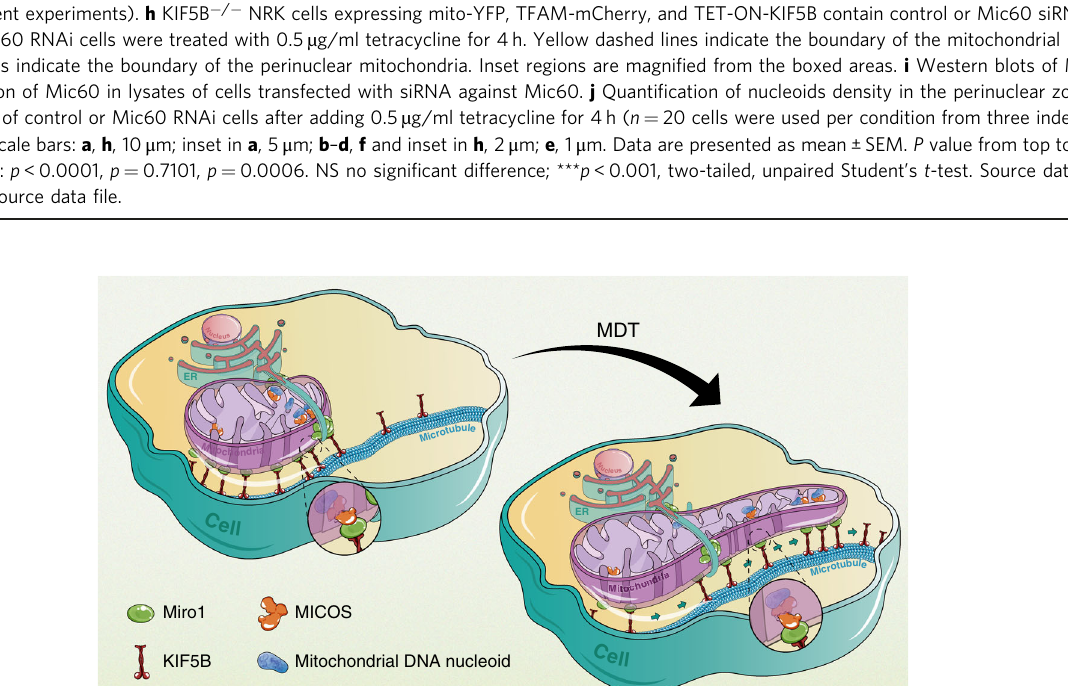
Fig. 6 The role of MDT in the partitioning of mitochondrial DNA nucleoids. At the ER – mitochondria contact sites, nucleoids interact with the inner membrane protein complex MICOS. MICOS is associated with the outer membrane protein Miro1, which is concentrated at the ER – mitochondria contact sites and recruits KIF5B motors on the mitochondria. When KIF5B-driven dynamic tubulation happens, nucleoids are transported via the interaction axis of dilution. We also used horseradish peroxidase-conjugated goat anti-rabbit (7074 S, Cell Signaling Technology, 1:5000 dilution) or goat anti-mouse secondary antibodies (31436, Invitrogen, 1:5000 dilution) and the signal was detected with SuperSignal West Pico PLUS Chemiluminescent Substrate (ThermoFisher Scienti fi c). Image lab (version 5.0) was used for western blotting images collection. Uncropped blots can be found in the Source data fi le. Immunoprecipitation . Cells were lysed in lysis buffer (25mM Tris-HCl pH 7.4; 1% NP-40; 150mM NaCl; 1mM EDTA; and 5% glycerol) containing protease inhi- bitors (Sigma-Aldrich). The lysed samples were incubated with mouse anti-Mic60 (ab110329; Abcam) or normal mouse IgG (A7028; Beyotime). After overnight incubation with gentle mixing at 4°C, protein A + G agarose bead (P2012; Beyotime) was added to each sample and mixed for 3h at 4°C. Immunoprecipi- tates were washed extensively in lysis buffer, and bound complexes were separated by SDS – PAGE and transferred to a polyvinylidene di fl uoride membrane. For immunodetection, mouse anti-Mic60 (ab110329; Abcam) and mouse anti-Miro1 (WH0055288M1; Sigma-Aldrich) were used at 1:1000; rabbit anti-TFAM (HPA040648; Sigma-Aldrich) was used at 1:100. Immuno fl uorescence . Cos-7 cells were seeded on preincubated coverslips in 35- mm dishes and transfected with plasmids, as previously described. The next day, we washed slides in PBS, fi xed them in 6% paraformaldehyde in PHEM buffer (60 mM pipes (pH 6.9), 25 mM Hepes, 10 mM EGTA, and 2mM MgCl 2 ) for 15min at 20 °C, and washed the seeded coverslips three times with PHEM buffer, before incubating them for 30min at room temperature with 10% BSA (Jackson, #001-000-162) and 0.5% TritonX-100 (ThermoFisher Scienti fi c) in PHEM buffer. Next, we incubated the cells with primary antibodies (anti-Miro1, mouse mono- clonal (WH0055288M1; Sigma-Aldrich), 1:2000 dilution; anti-Miro1, rabbit poly- clonal (PA5-72835; Invitrogen); anti-DNA, mouse monoclonal (AC-30-10, Progen), 1:200 dilution; and anti-Mito fi lin, rabbit polyclonal (10179-1-AP, Pro- teintech), 1:50 dilution) in BSA with 0.05% TritonX-100 for 1 – 2h. The cells were